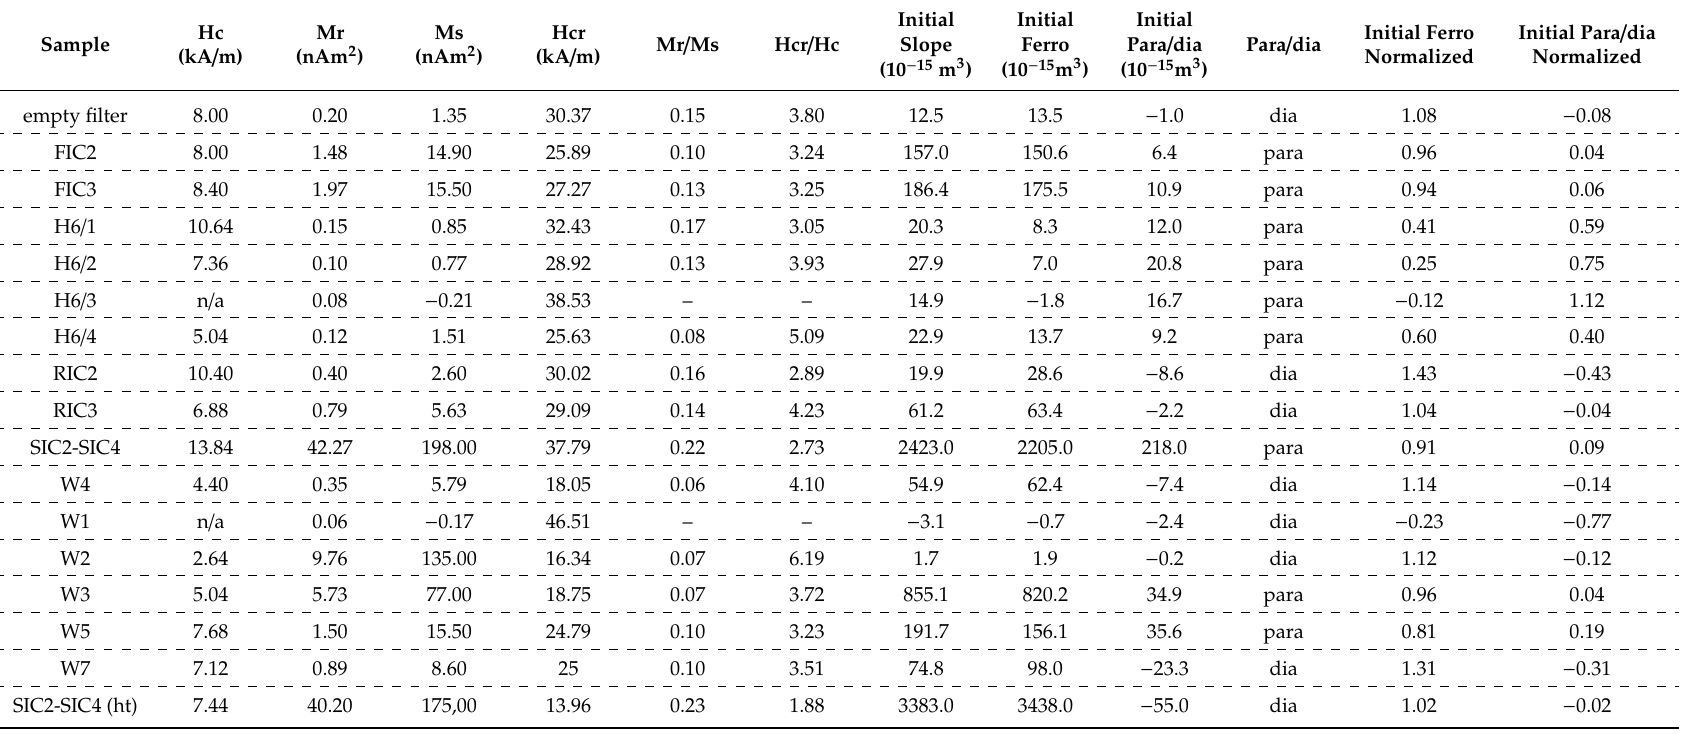
Table A3. For signal after para- / diamagnetic slope correction: coercivity (Hc), magnetic remanence moment (Mr), saturation moment (Ms), the coercivity of remanence; data not normalized per mass / volume. Initial slope parameters for an initial magnetization curve to calculate the contribution of para- / dia- and ferromagnetic components for low field susceptibility. Location of samples according to Table 2. Data for Hc, Mr and Ms were obtained after processing with Hystlab software [39]; Hcr data were calculated with the AGM magnetometer